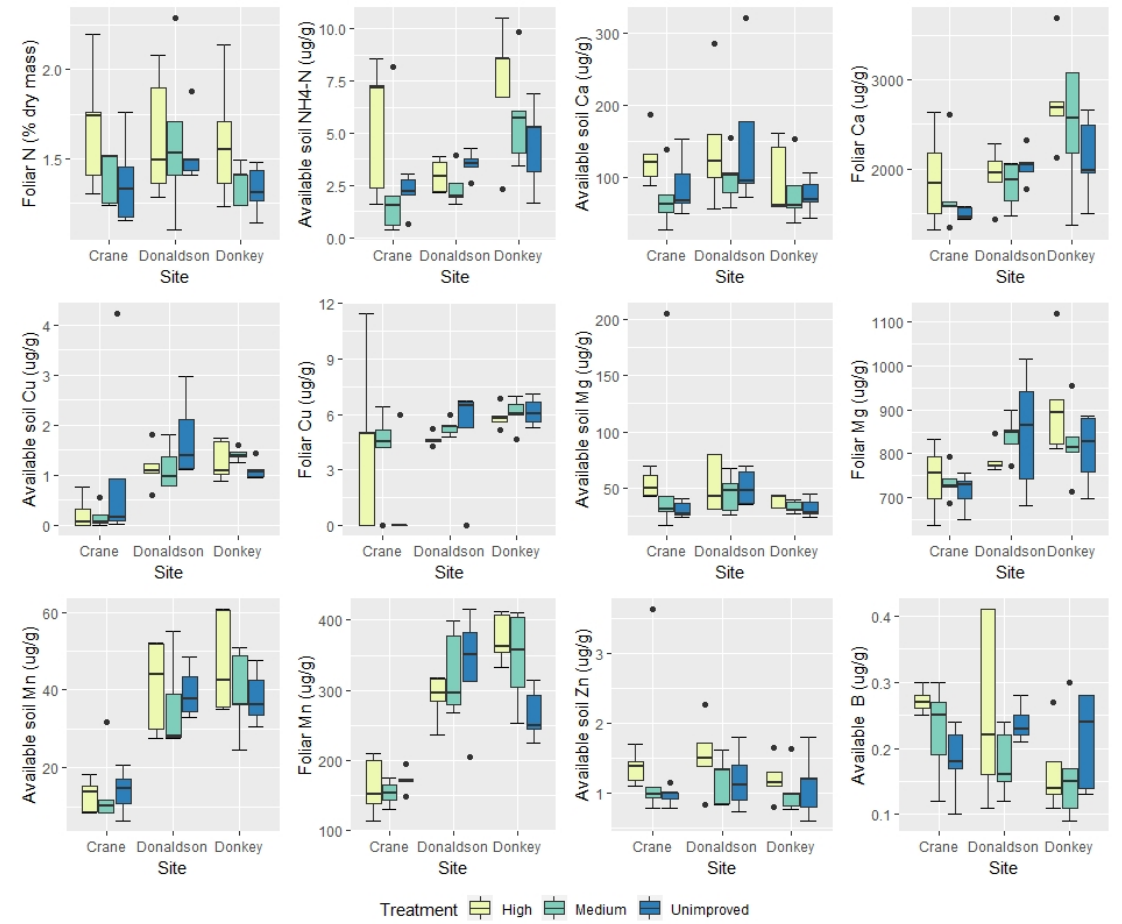
Figure 4. Soil and foliar nutrients across different sites and genetic gain levels. Soil and foliar nutrients for the same element are shown in pairs.